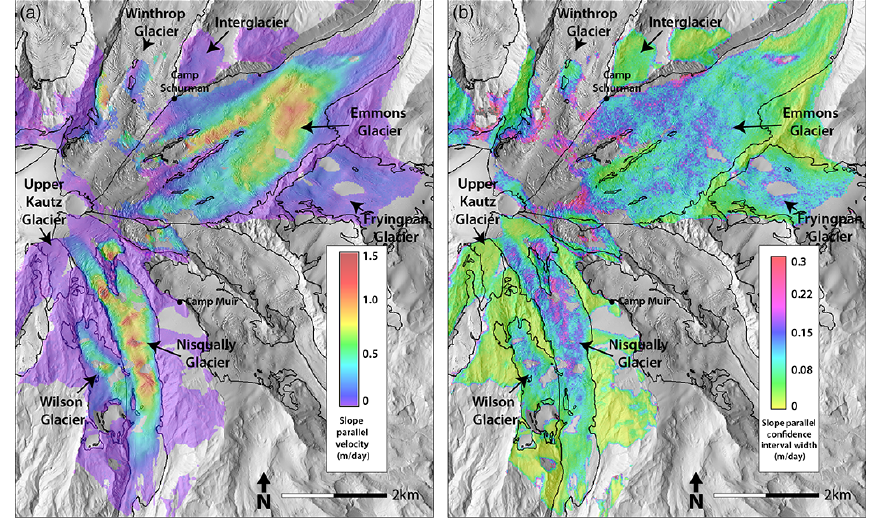
Figure 3. (a) Median slope-parallel velocity derived from TRI for GLPEEK and SUNRIZ viewpoints taken on 6–7 July 2011. (b) Width of 95% confidence interval (high minus low limits for slope-parallel flow field) of slope-parallel velocities for 6–7 July 011 computed by bootstrapping after performing atmospheric noise corrections and stacking. Area shown is indicated by Box A on Fig.